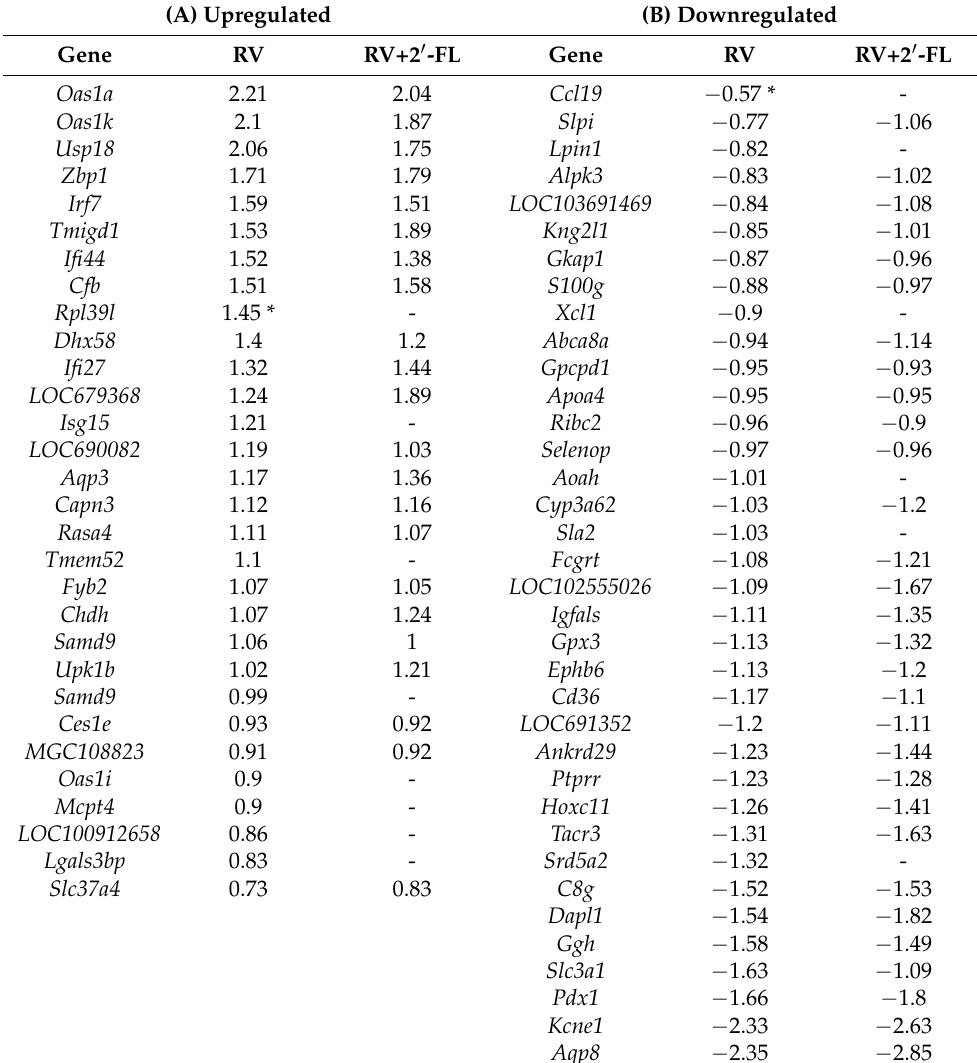
Table 1. List of partial genes (A) upregulated and (B) downregulated. (A) Upregulated (B) Downregulated Gene RV